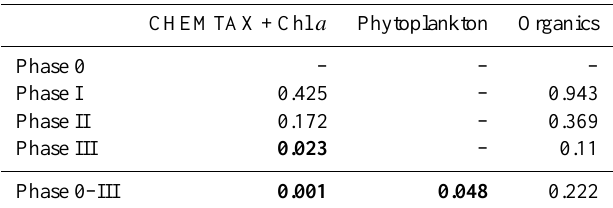
Table 3. Significance levels of the RELATE analyses for the CHEMTAX and Chl a , phytoplankton carbon biomass, and organ- ics (POC, PON, POP, DON and DOP) datasets. While a dashed line indicates that there were too few observations for an analysis, bold numbers highlight a statistical significance below the 5%